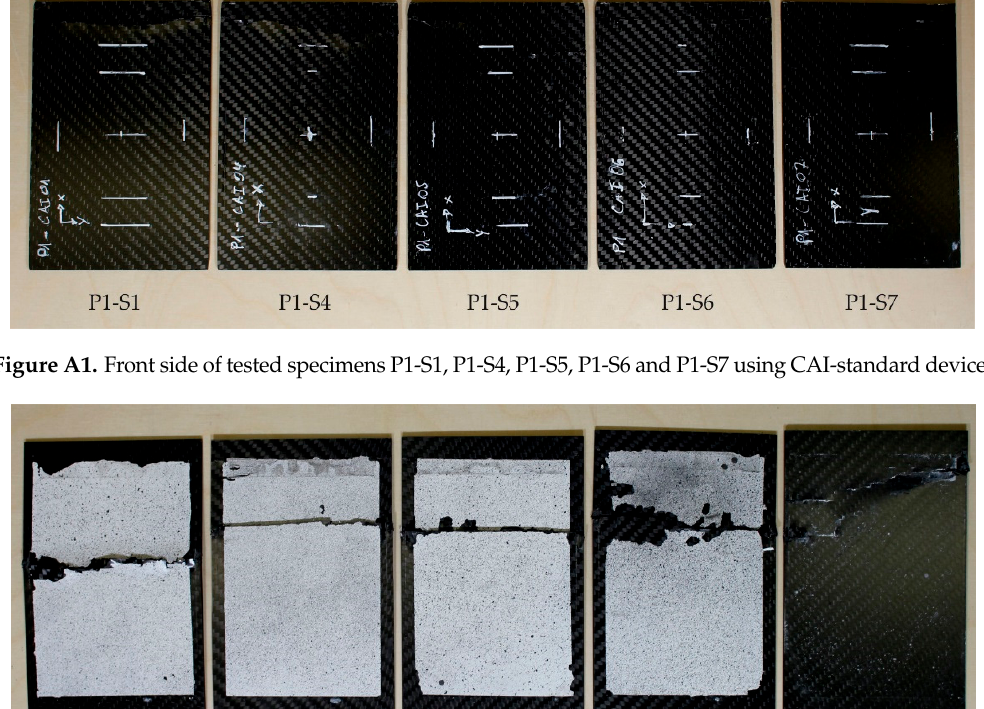
Figure A2. Front side of tested specimens P2-S3, P2-S5, P2-S8, P2-S9 and P2-S10 using CAI-modified device.